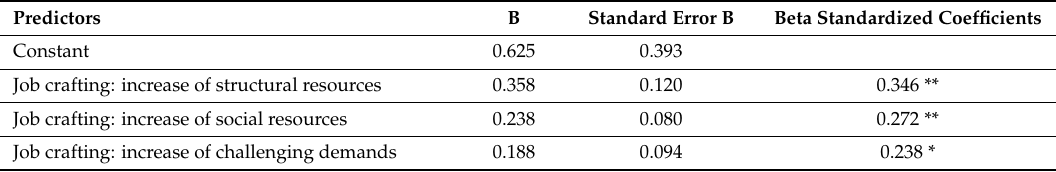
Table 3. Linear regression analysis on work